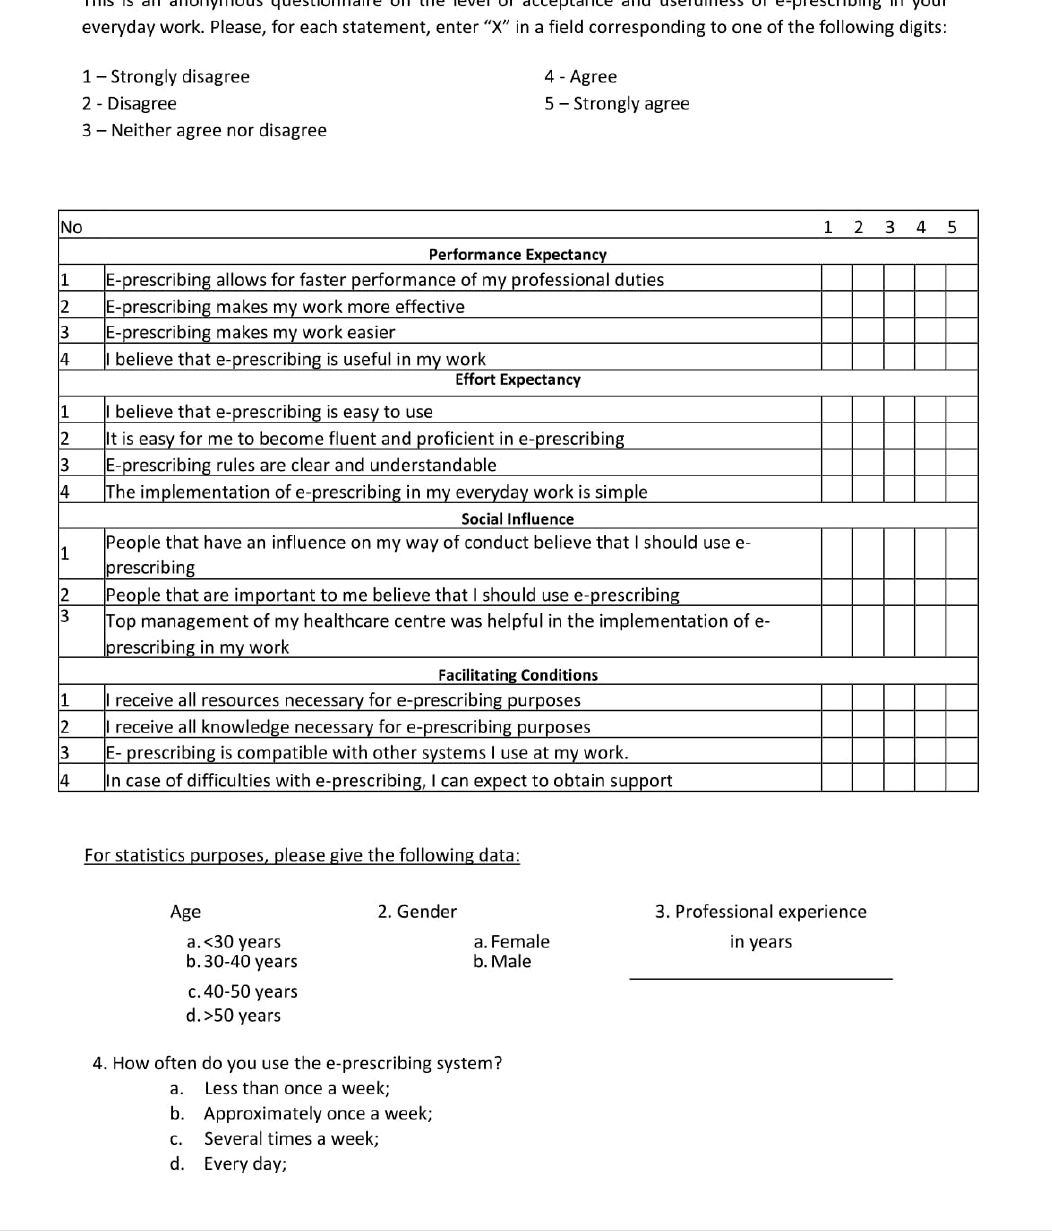
Figure 2. Original questionnaire used in the survey.